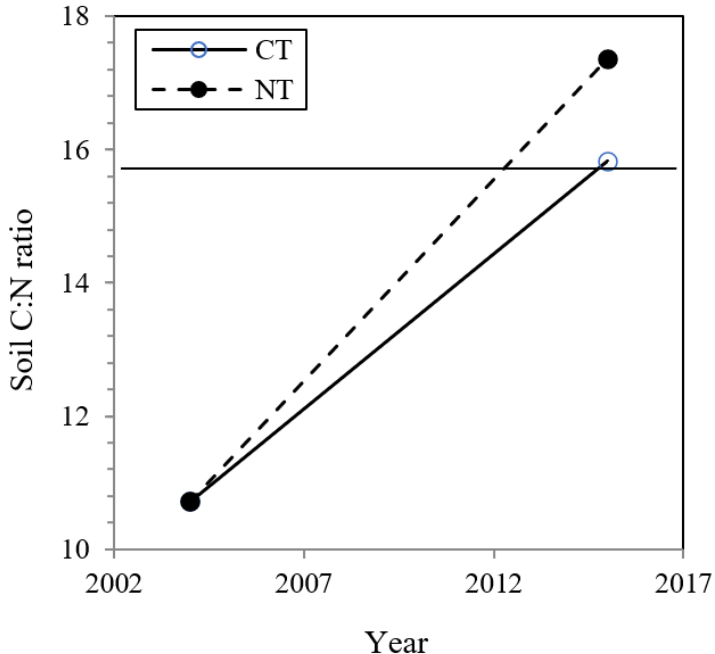
Soil sample with three replications using the five ‐ point method ( n =3). # Significant difference ( p < 0.05) between 2004 and 2016; SOC, soil organic matter; STN, soil total N; STP, soil total P; STK, soil total K; SNN, soil NaOH hydrolysable N; SOP, soil olsen P; SNK, soil NH 4 OAc extractable K. * are significantly different according to LSD at p < 0.05. ns are not significantly different according to LSD at p = 0.05.